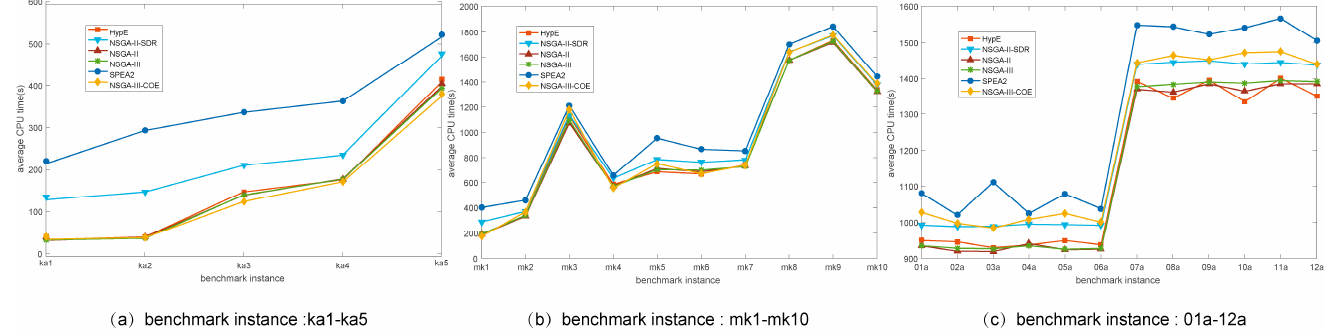
Figure 11. Average CPU time (in seconds) consumed by NSGA-III-COE and other comparison algorithms on 27 problem instances.